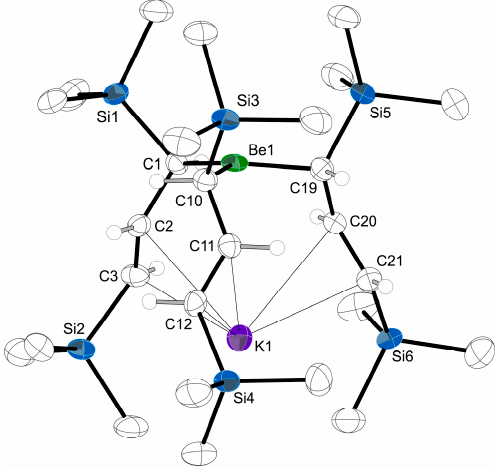
Figure 2. Thermal ellipsoid plot of 1 , illustrating the numbering scheme used in the text. Ellipsoids are drawn at the 50% level, and for clarity, hydrogen atoms have been removed from the trimethylsilyl groups. Selected bond distances (Å) and angles (deg): Be1–C1, 1.795(6); Be1–C10,